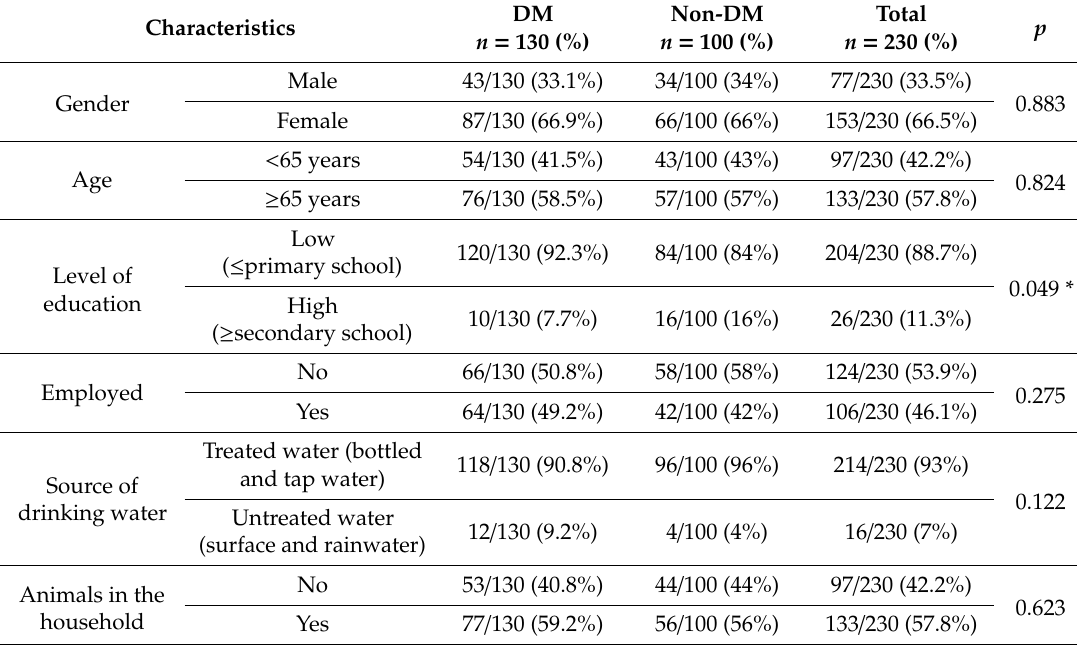
Table 2. Characteristics of study participants with diabetes mellitus (DM, n = 130) and without diabetes mellitus (Non-DM, n = 100).